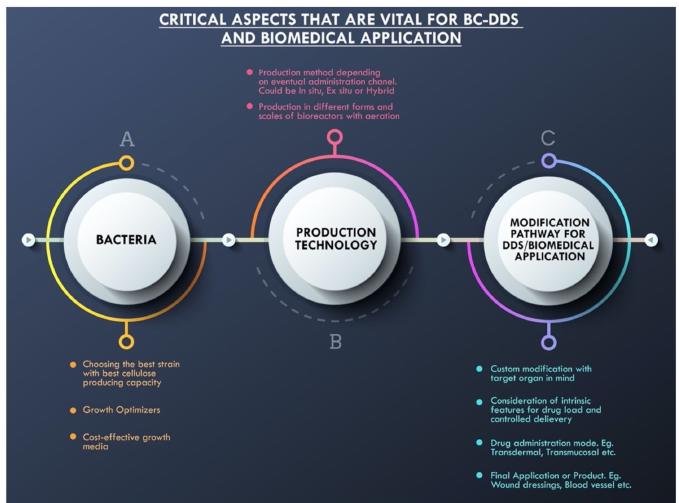
Figure 4. Illustration of the critical aspects vital for BC-DDS and biomedical